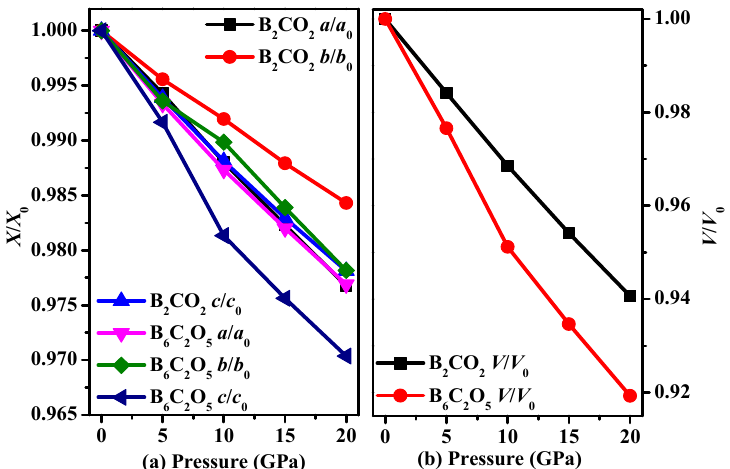
Figure 2. Lattice constants a / a 0 , b / b 0 , c / c 0 compression as functions of pressure for B 2 CO 2 and B 6 C 2 O 5 ( a ); and primitive cell volume V / V 0 for B 2 CO 2 and B 6 C 2 O 5 ( b ).